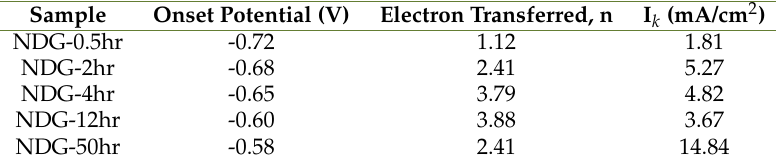
Table 3. Summarize of ORR kinetic parameters of all